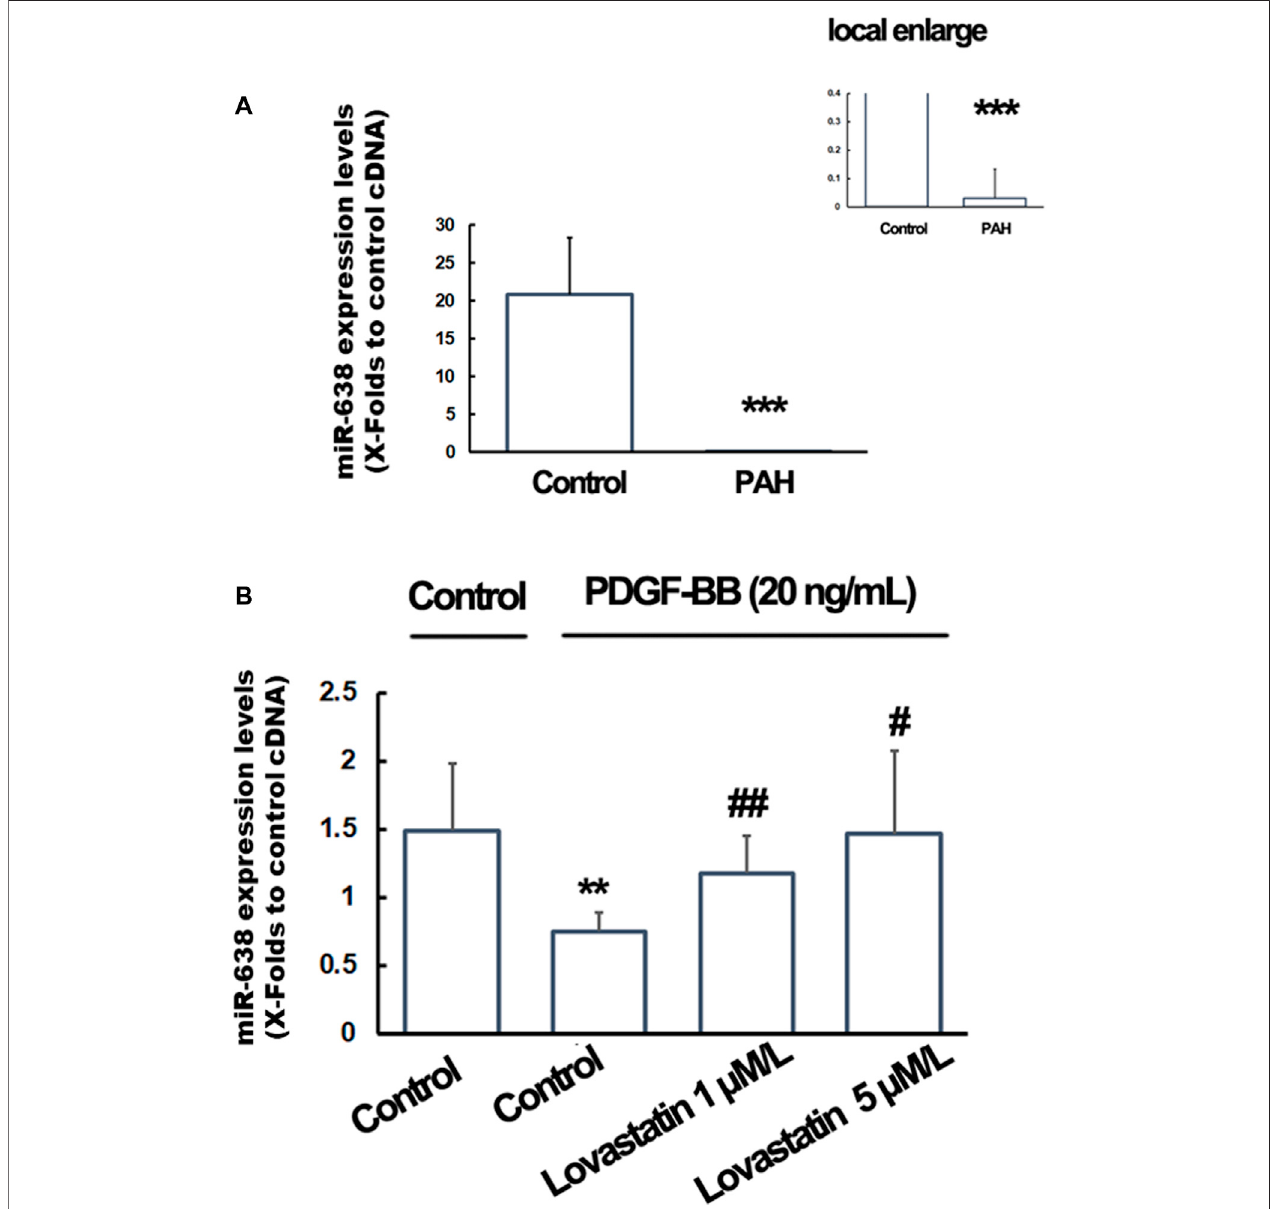
FIGURE4| ExpressionofmiR-638inPAHpatientsandlovastatintreatedPASMCs.TotalRNAfromtheplasmaofPAHpatientsandhPA-SMCswereisolatedwith the use of Trizol and the expression levels of miR-168 were detected using qRT-PCR. (A) . The plasma miR-638 levels were signi fi cantly decreased in PAH patients ( n (cid:2) 20)comparedwithcontrolsindividuals( n (cid:2) 30).DatawasexpressedasMean ± SD.* p < 0.05,** p < 0.01,*** p < 0.001vsthenormalcontrol.U48wereusedasacontrol gene. (B) . The starved human PA-SMC were pre-treated with lovastatin at a fi nal concentration of 0, 1or 5 μ M/L, followed by incubated with PDGF-BB at a fi nal concentrationof20 ng/ml. 1%DMSO wereused asasolventcontrol.The U6wereused asacontrolgene. Datawasexpressed asMean ± SD. * p < 0.05,** p < 0.01vs. the normal control. # p < 0.05, ## p < 0.01 vs. the PDGF-BB treated cells.